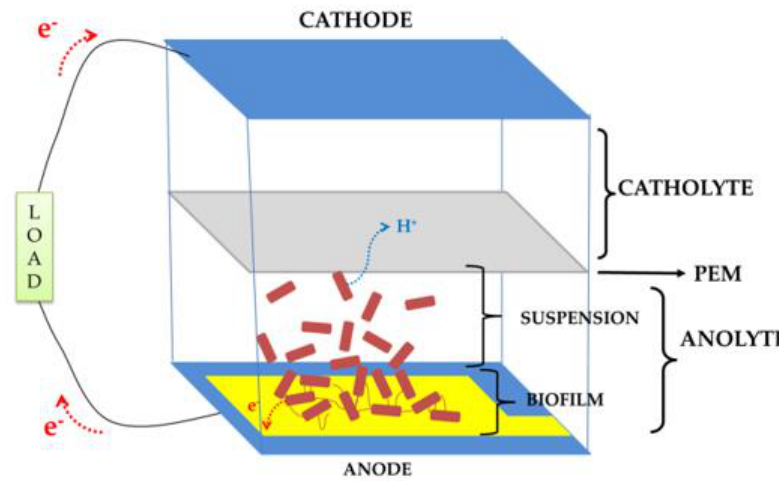
Figure 1. A double-chamber bioanode Microbial Fuel Cell (MFC) schematic.